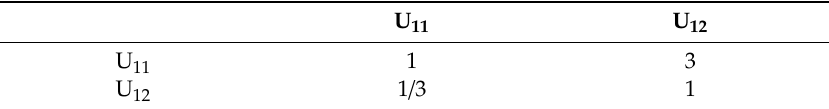
Table 8. Judgment matrix of the safety